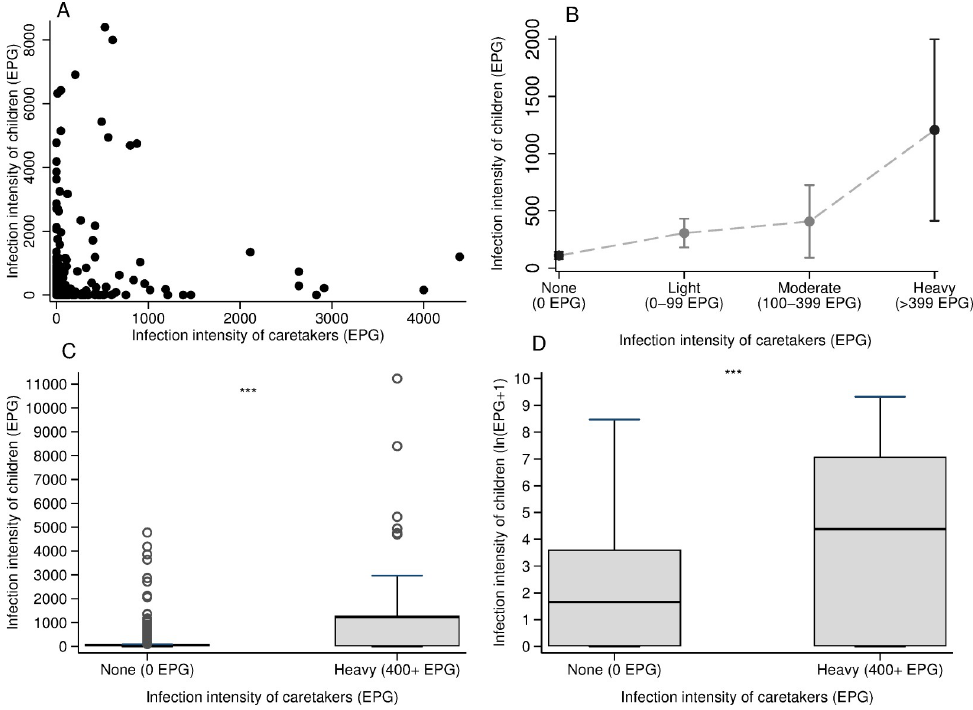
Fig 6. Mean S . mansoni infection intensity in children by the level of infection of their caretakers. A) Scatter plot of the distribution of infection intensities of children and caretakers. One child and one adult (outliers) with over 11,000 EPG were replaced to the closest highest number for EPG in this plot. B) Mean egg count of children with the corresponding 95% confidence intervals against the level of infection of caretakers. C) Box plot comparing the mean infection intensity for children whose caretakers were not infected (0 EPG) (Mean: 110.2 EPG; SD: 418.1) vs the mean infection intensity for children whose caretakers were highly infected (400+ EPG) (Mean: 1288.9 EPG; SD: 2526.6; two sample t-test = 9.9, p-value < 0.001 ��� ) D) Box plot comparing the log-transformed mean infection intensity for children whose caretakers were not infected (0 EPG)) (Mean: 1.7 ln(EPG+1); SD: 1.4) vs the mean infection intensity for children whose caretakers were highly infected (400+ EPG) (Mean: 4.4 ln(EPG+1); SD: 3.2; two sample t-test = 6.9, p- value < 0.001 ��� ). The infection intensity of children was log-transformed as the raw distribution was highly skewed. In C and D, the boxes indicate the upper and lower interquartile range (IQR), the horizontal line in the box represents the mean, the whiskers represent -\+ 1.5 � IQR and the hollow circles represent the data points with a value above 1.5 � IQR.